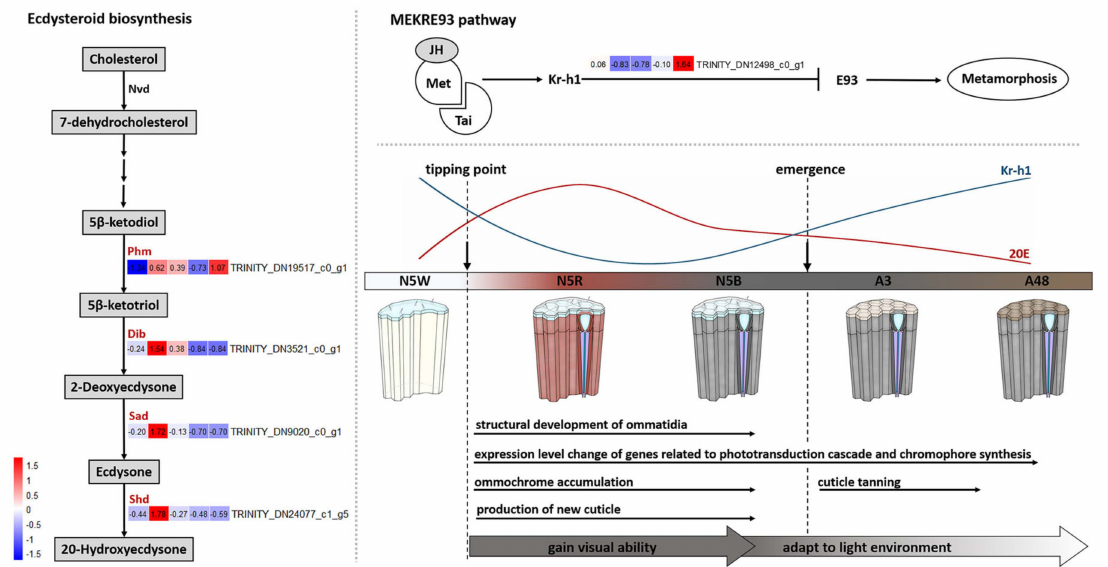
Figure 7. Expression patterns of key DEGs related to hormone biosynthesis. Ecdysteroid biosyn- thesis pathway is related to the genes encoding ecdysteroid 25-hydroxylase (phm), ecdysteroid 22- hydroxylase (dib), and ecdysteroid 2-hydroxylase (sad), ecdysteroid 20-hydroxylase (shd). MEKRE93 pathway is related to the gene encoding the Krüppel homolog 1 (Kr-h1). The heatmaps based on TPM show the expression levels of the corresponding protein or enzyme genes in five development stages (from left to right, the 5th-instar with white compound eyes (N5W), with red compound eyes (N5R), with dark brown compound eyes (N5B), and the adults after emergence at 3 h (A3), 48 h